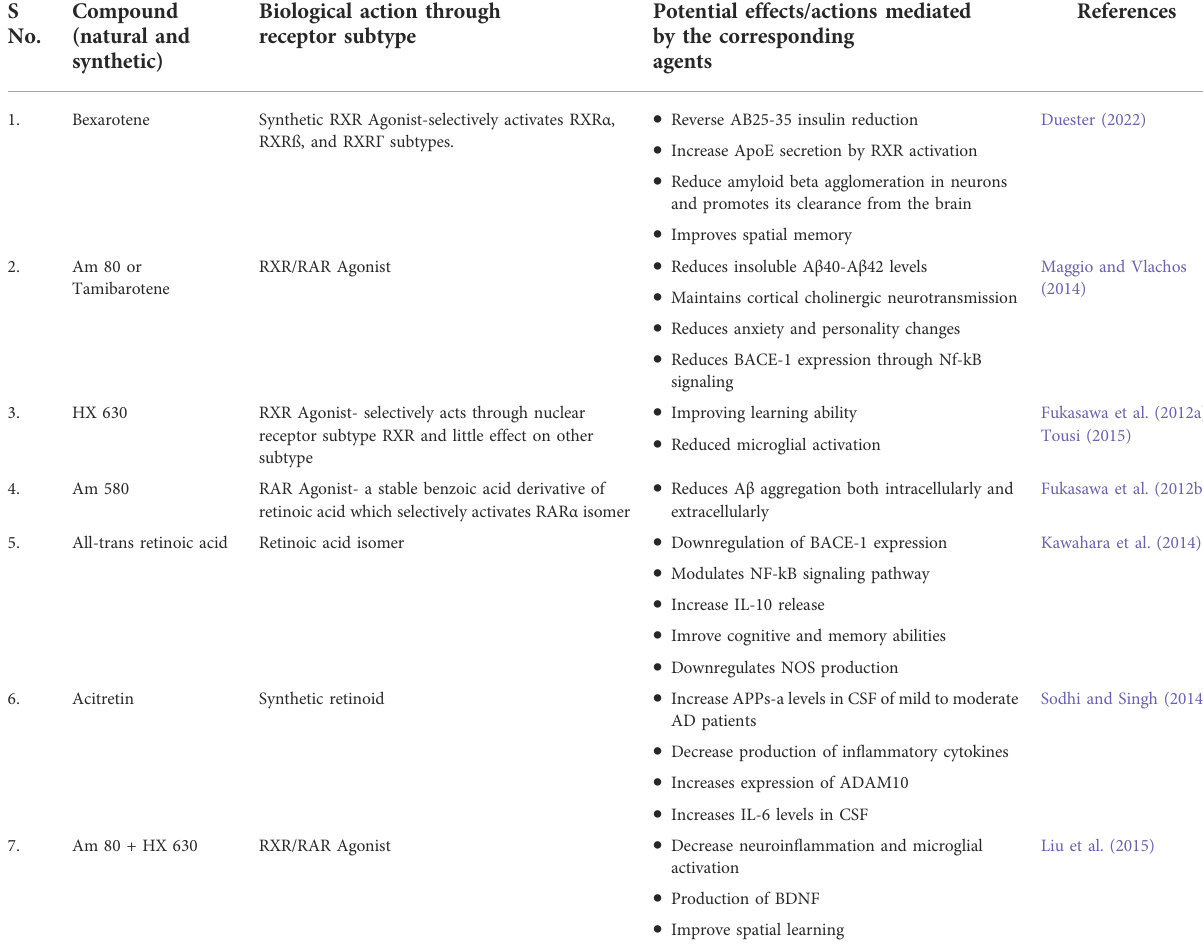
TABLE 1 The schematic data revealing the potential role of synthetic and natural retinoids as well as vitamin A derivatives in ameliorating the pathogenesis of Alzheimer ’ s disease in various experimental models through distinct mechanisms/pathways. S